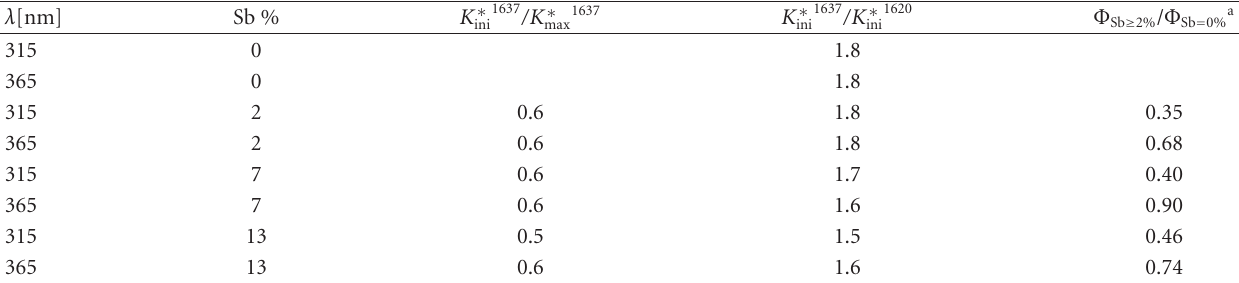
Table 5: Influence of Sb-doping on K ∗ ini1637 /K ∗ max1637 and K ∗ ini1637 /K ∗ ini1620 ; λ = 315 or 365